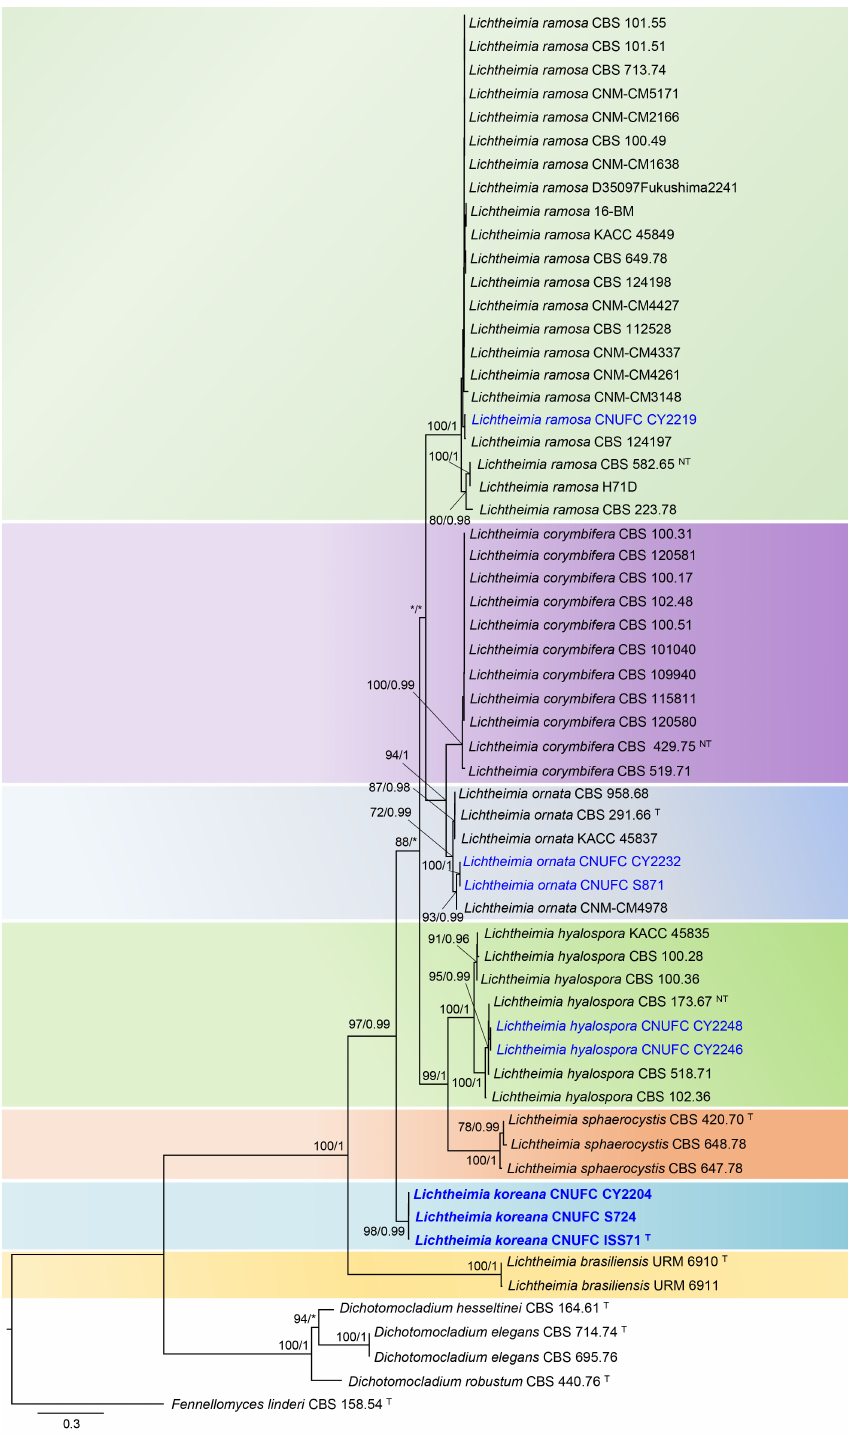
Figure 1. Phylogram generated from the Maximum Likelihood (RA × ML) analysis based on the combined ITS and LSU sequence data of Lichtheimia spp. and Dichotomocladium spp. The numbers above or below branches represent maximum likelihood bootstrap percentages ( left ) and Bayesian posterior probabilities ( right ). Bootstrap values ≥ 70% and Bayesian posterior probabilities ≥ 0.95 are indicated above or below branches. Bootstrap values lower than 0.95 and 70% are marked with “*”. Fennellomyces linderi CBS 158.54 was used as the outgroup. The newly generated sequences are indicated in blue and new species are in bold. T = type strain; NT = neotype